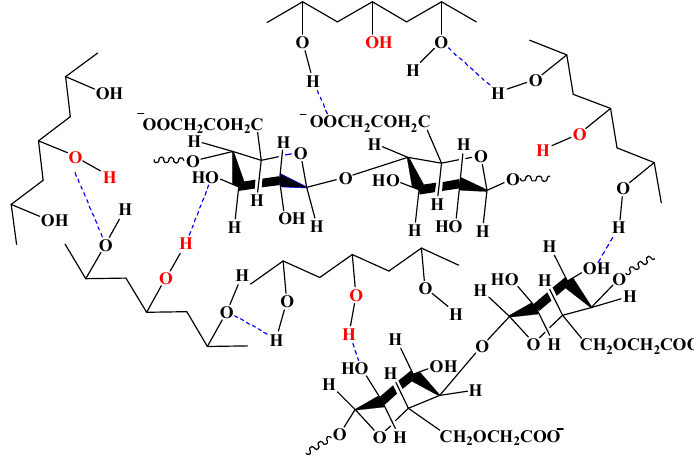
Figure 9. The reaction mechanism for PVA, CMC, and Na 2 CO 3.